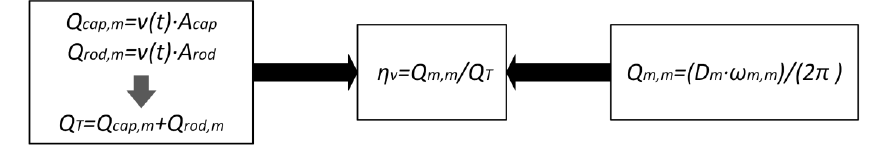
Figure 18. The calculation process of the measured volumetric efficiency.